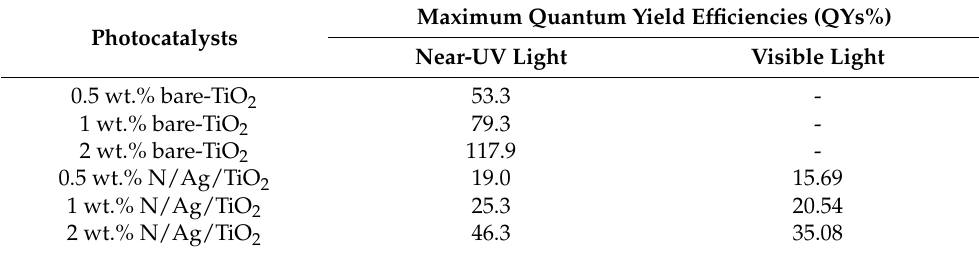
Table 6. Percentage quantum yields (QYs%) for the photocatalytic degradation of methanol (90 µ mol/L) using either a bare-TiO 2 photocatalyst or a N/Ag/TiO 2 photocatalyst, coated on a mesh at different loadings: 0.5 wt.%, 1 wt.%, and 2 wt.%. Maximum Quantum Yield Efficiencies (QYs%) Photocatalysts Near-UV